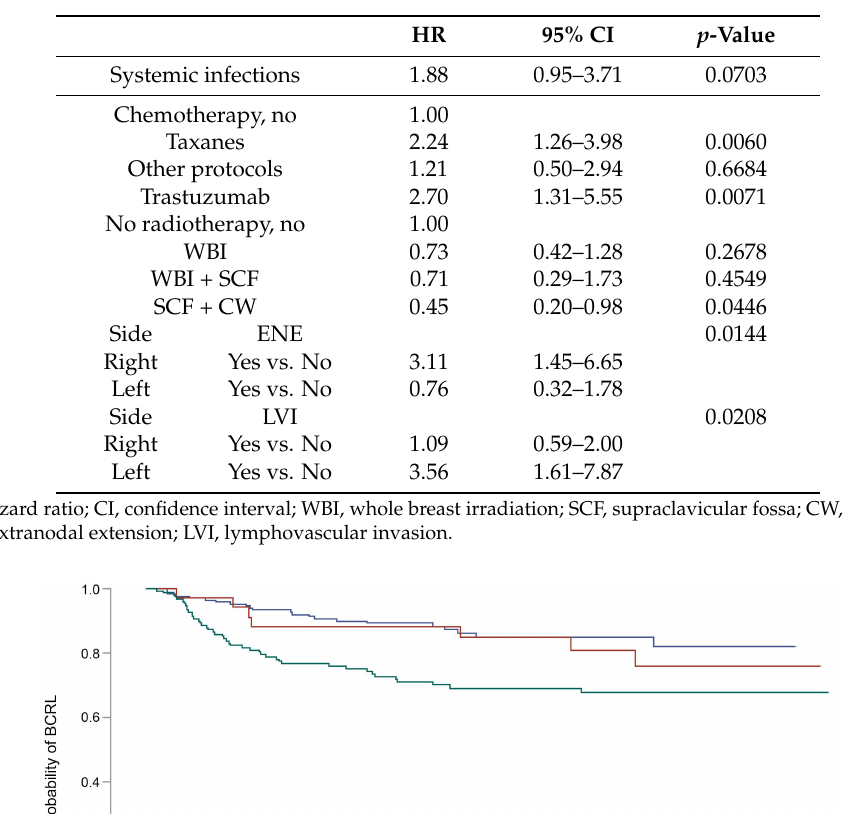
Clinicopathologic factors associated with the development of breast cancer related lymphedema (Cox proportional hazard model).